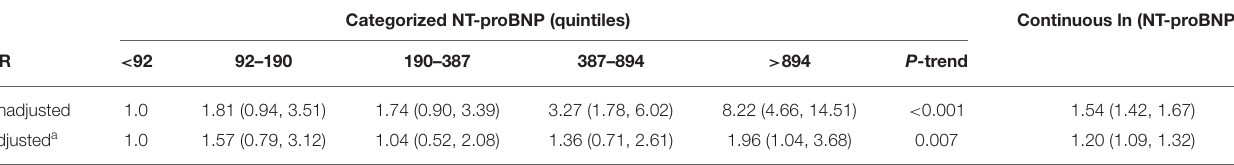
TABLE 3 | The P trend test for the correlation of pre-operative N-terminal pro-B-type natriuretic peptide with acute kidney injury after noncardiac surgery.